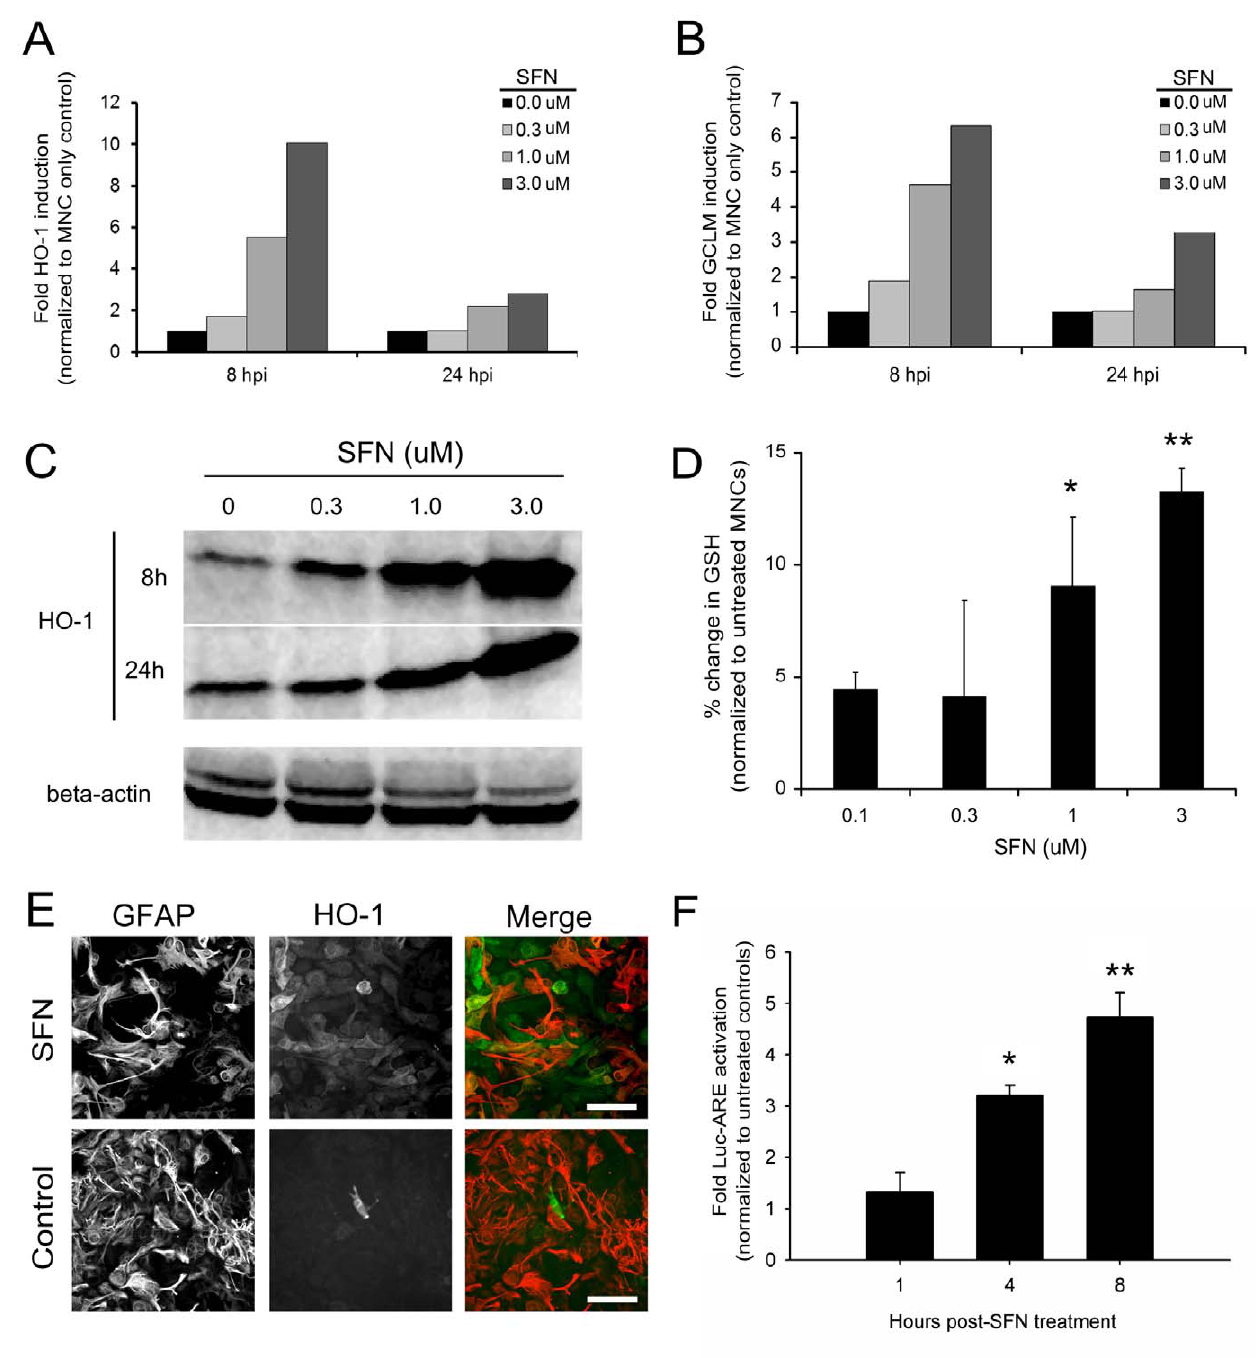
Figure 5. Sulforaphane elevates HO-1 expression via Nrf2/ARE activation in astrocytes. SFN (0, 0.3, 1.0 or 3.0 m M) was added onto MNC for 8 & 24 h prior to collection for semi-quantitative RT-PCR ( A & B ) and Western blot ( C ) analysis. RT-PCR of HO-1 ( A ) and GCLM ( B ) mRNA expression in MNCs following 8 & 24 h exposure to SFN. Data are presented as fold induction over saline controls and are representative of 3 separate experiments. ( C ) Western blot analysis of HO-1 protein expression in MNCs following 8 & 24 h exposure to SFN. ( D ) GSH concentration in MNCs following 48 h exposure to SFN (p # 0.0001). ( E ) SFN treated MNC (24 h) stained for HO-1 (green) and GFAP (red). Scale=50 m m. ( F ) ARE-Luciferase reporter assay in purified astrocyte cultures following 4 and 8 h SFN treatment. *p=0.007; **p=0.006. Statistical significance was tested using an ANOVA single factor with PLSD Post-hoc analysis (StatView 5).